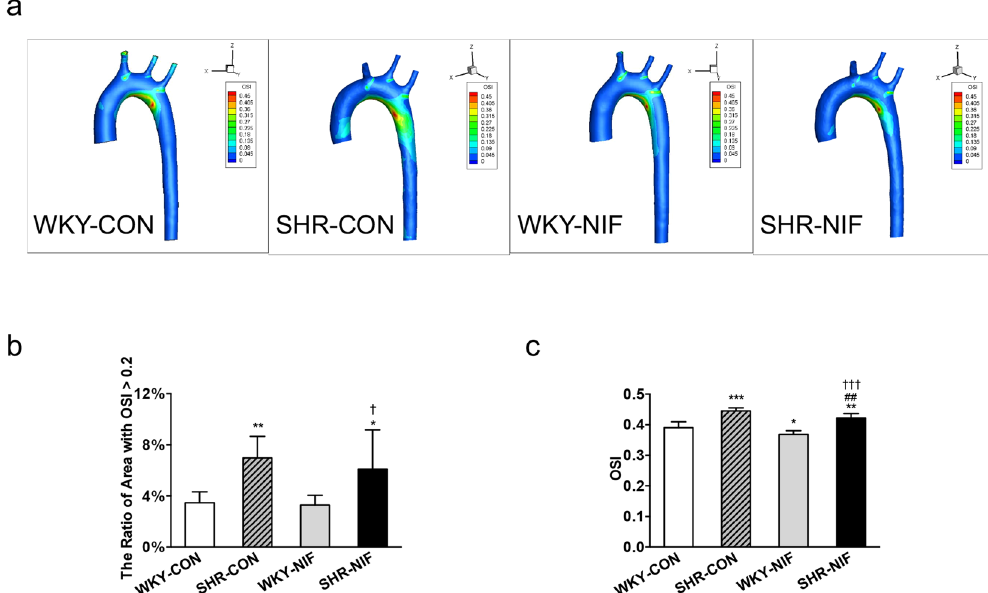
Figure 1. The OSI was significantly elevated in antihypertensive-treated SHRs compared with WKYs. ( a ) Contour plots of the OSI values averaged over one cardiac cycle analysed from aorta models in SHRs and WKYs. The OSI scale ranges from 0 (dark blue) to 0.5 (red). ( b ) The ratio of the area with an OSI > 0.2 of the whole geometry and ( c ) the OSI values in a region near the inner wall of the aortic arch are shown. Values are presented as the mean ± SD. (n = 6). * P < 0.05, ** P < 0.01, *** P < 0.001, vs WKY-CON. ## P < 0.01, vs SHR- CON. † P < 0.05, ††† P < 0.001, vs WKY-NIF. CON, control; NIF,